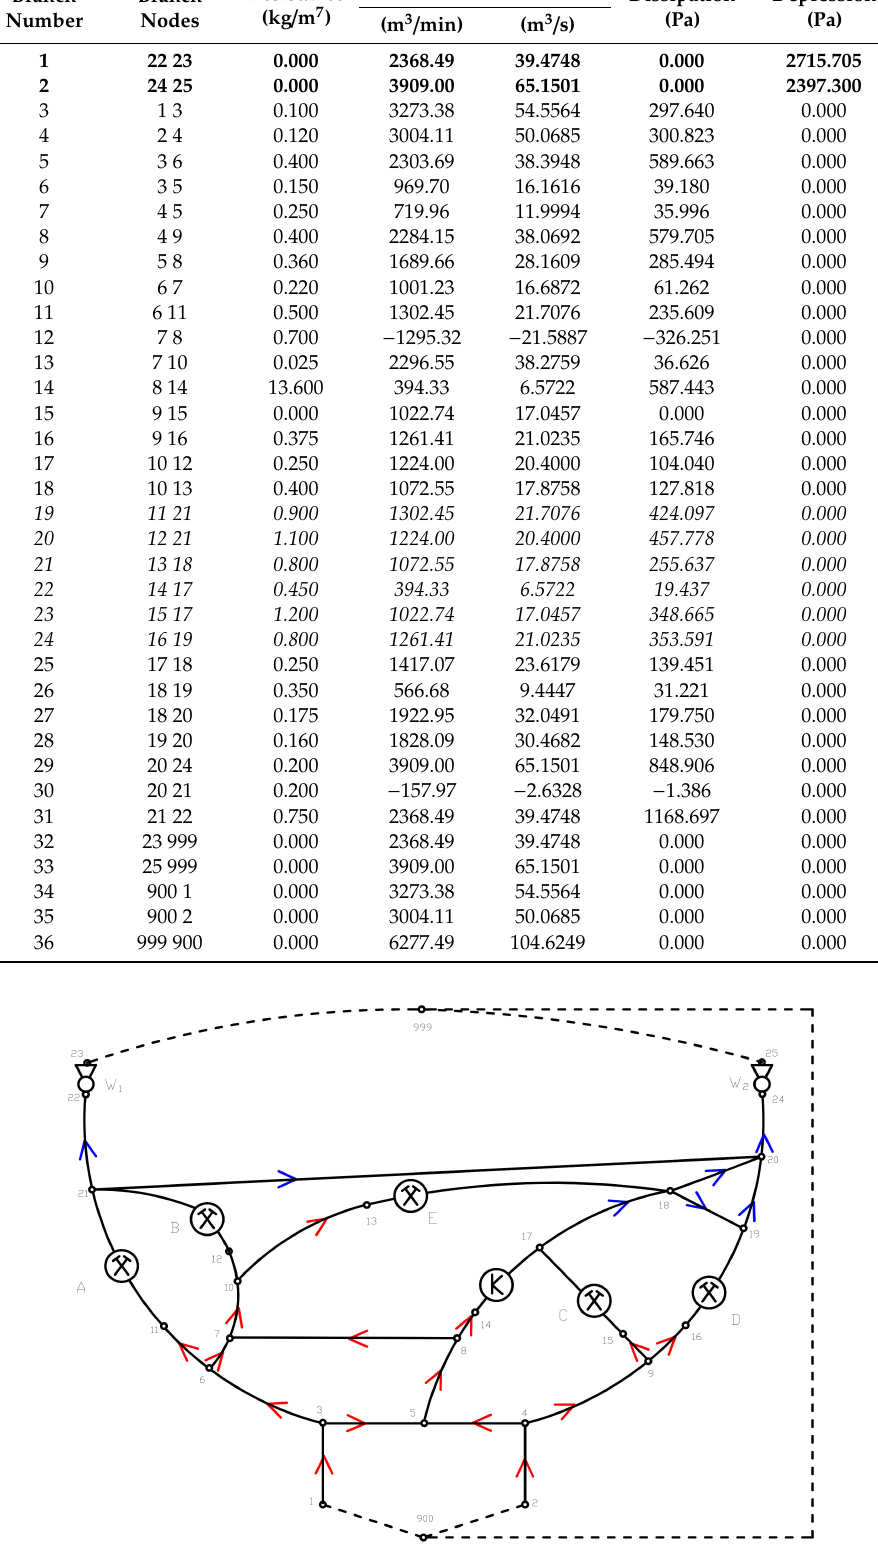
Figure 3. Canonical scheme of mine B (own